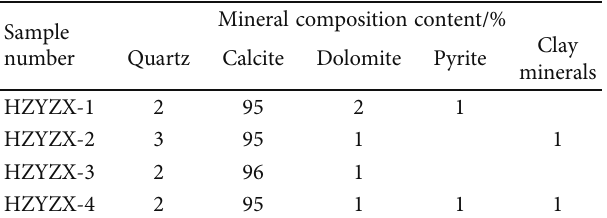
Table 1: XRD results of carbonate rocks forming the